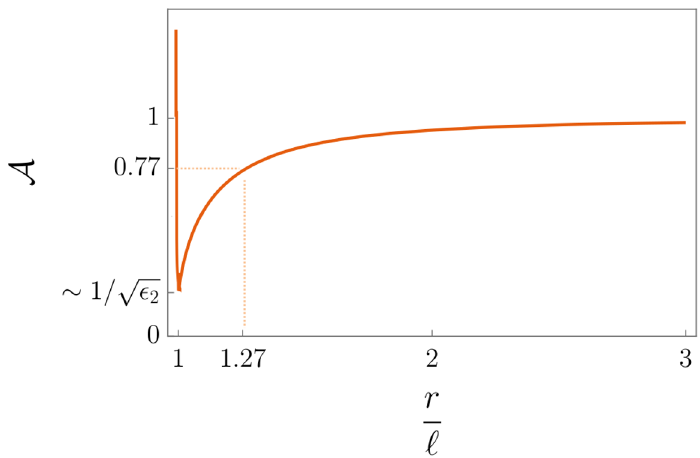
Figure 11 . Asymmetry factor of the S 2 for the bound states of extremal black holes (3.37) with (cid:15) 2 = 2 × 10 − 2